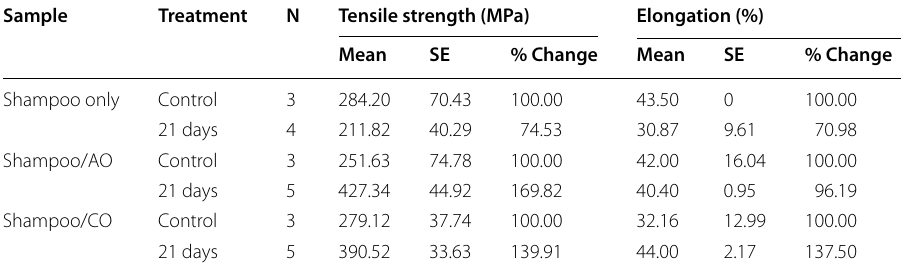
Table 9 Tensile strength and elongation of bleached hair shampooed with or without the use of hair conditioner containing Argan oil (AO) or Camellia oil (CO)